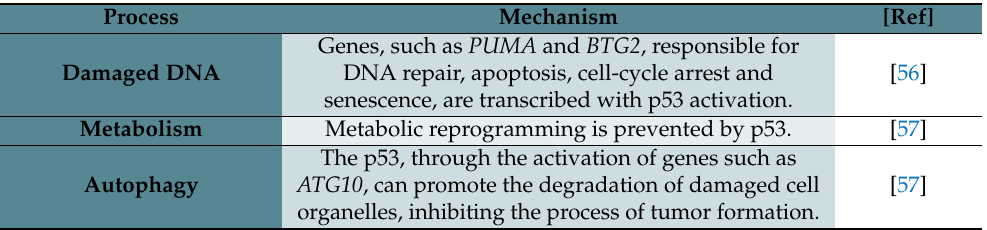
Table 1. The role of p53 in different cellular biological processes.